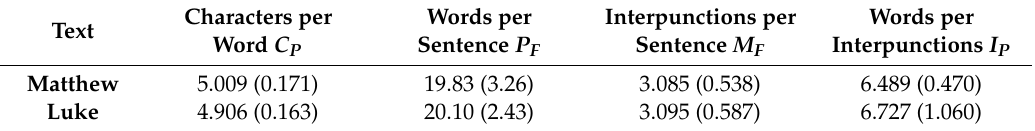
Table 6. Double Tradition. Average number of characters per word C P , words per sentence P F , interpunctions per sentence (also, number of word intervals) M F , words per interpunctions (word interval) I P . The numbers between parentheses give the standard deviations for text blocks of 500 words.